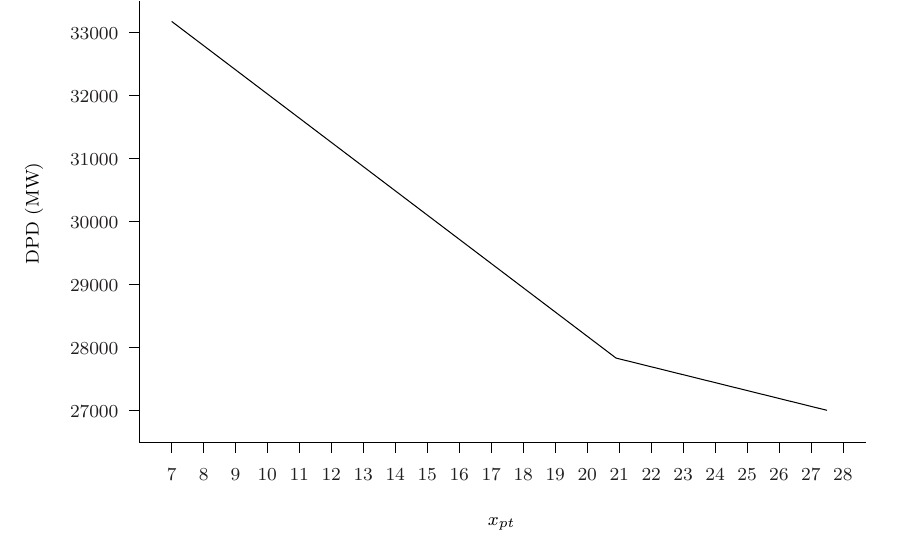
Figure 5: DPD as a function of temperature according to MARS model